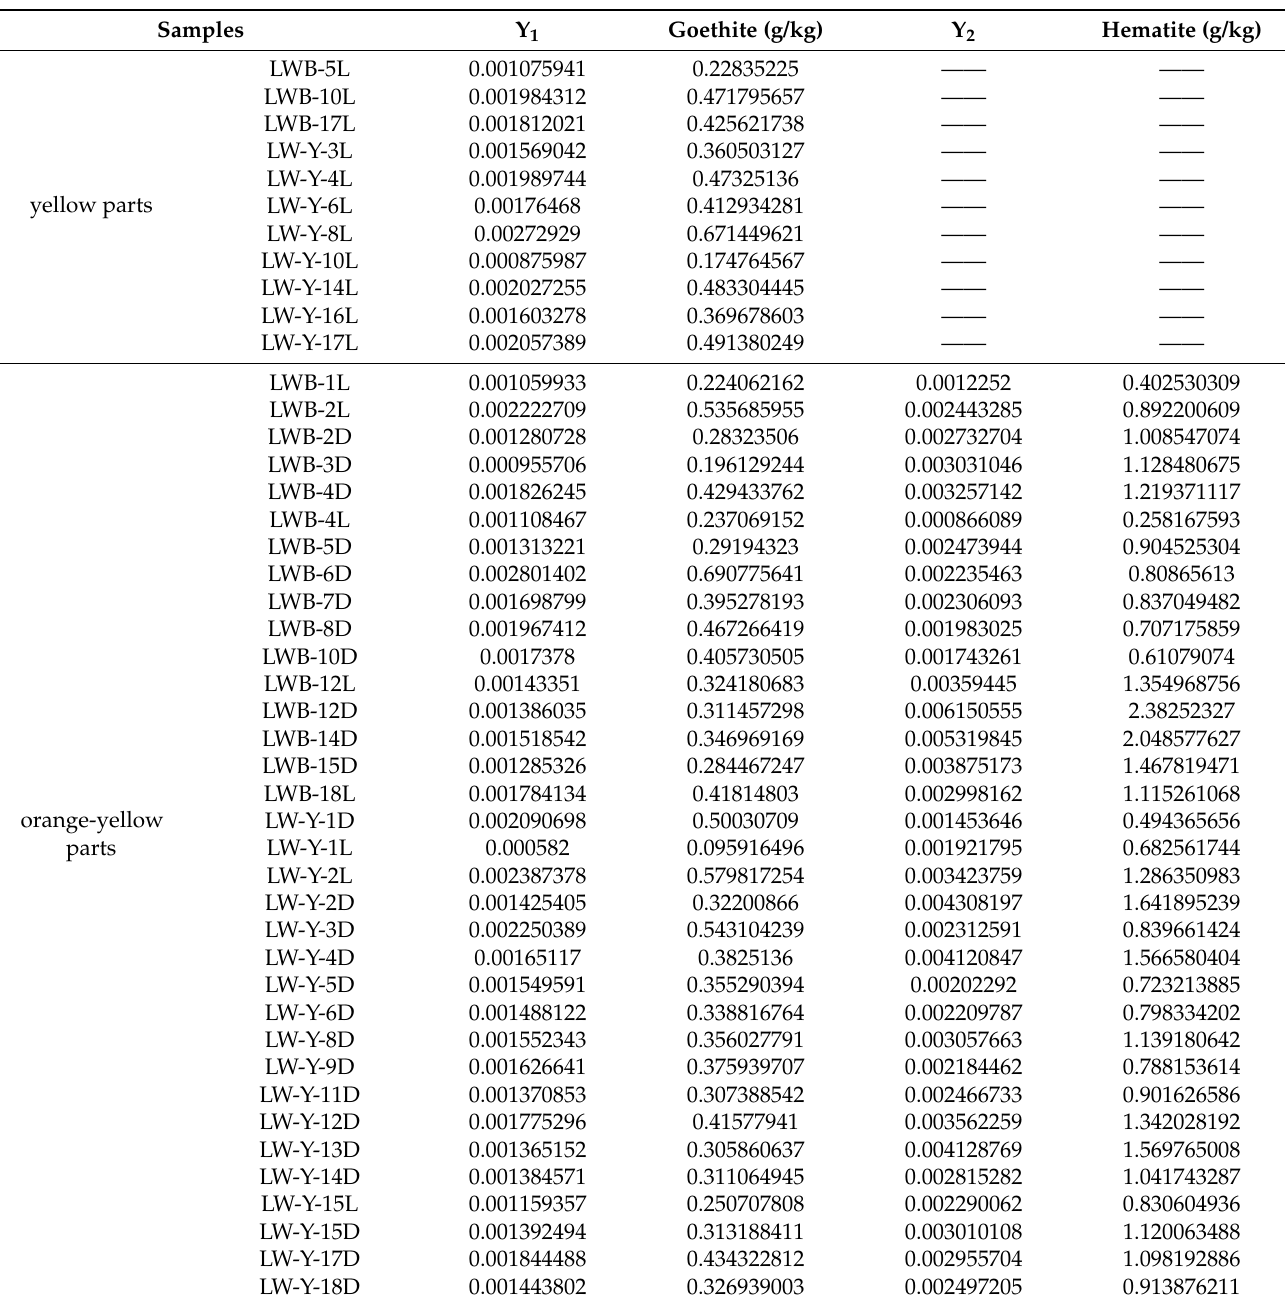
Table 2. Content of goethite and hematite estimated from K-M 2nd derivative spectra.